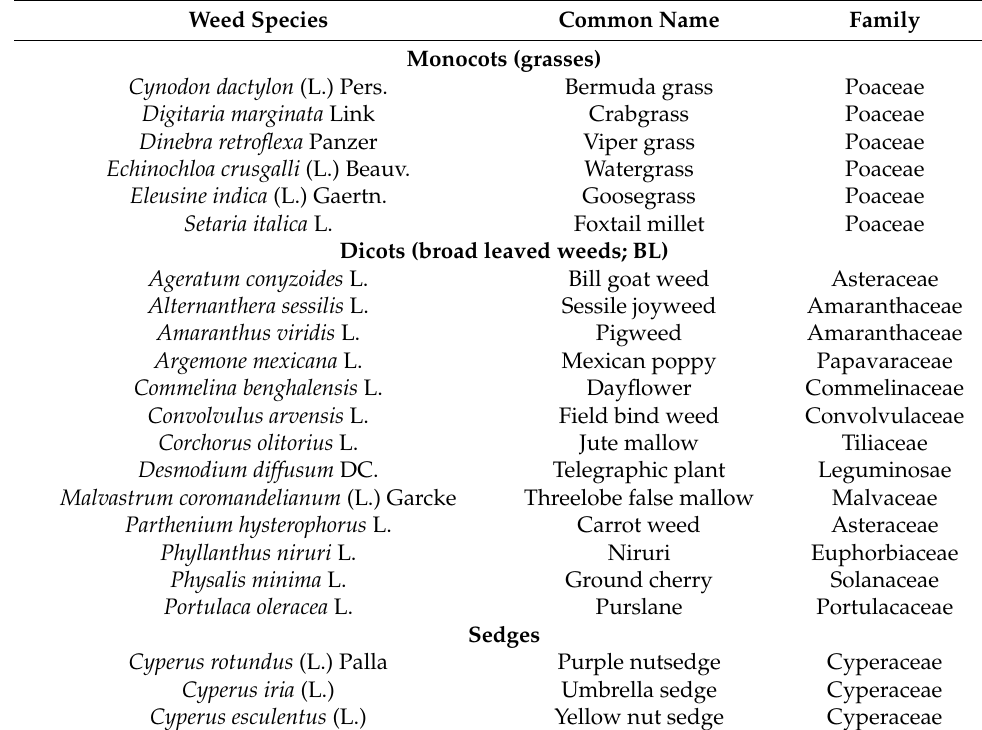
Table 2. Important weed species reported at the experimental